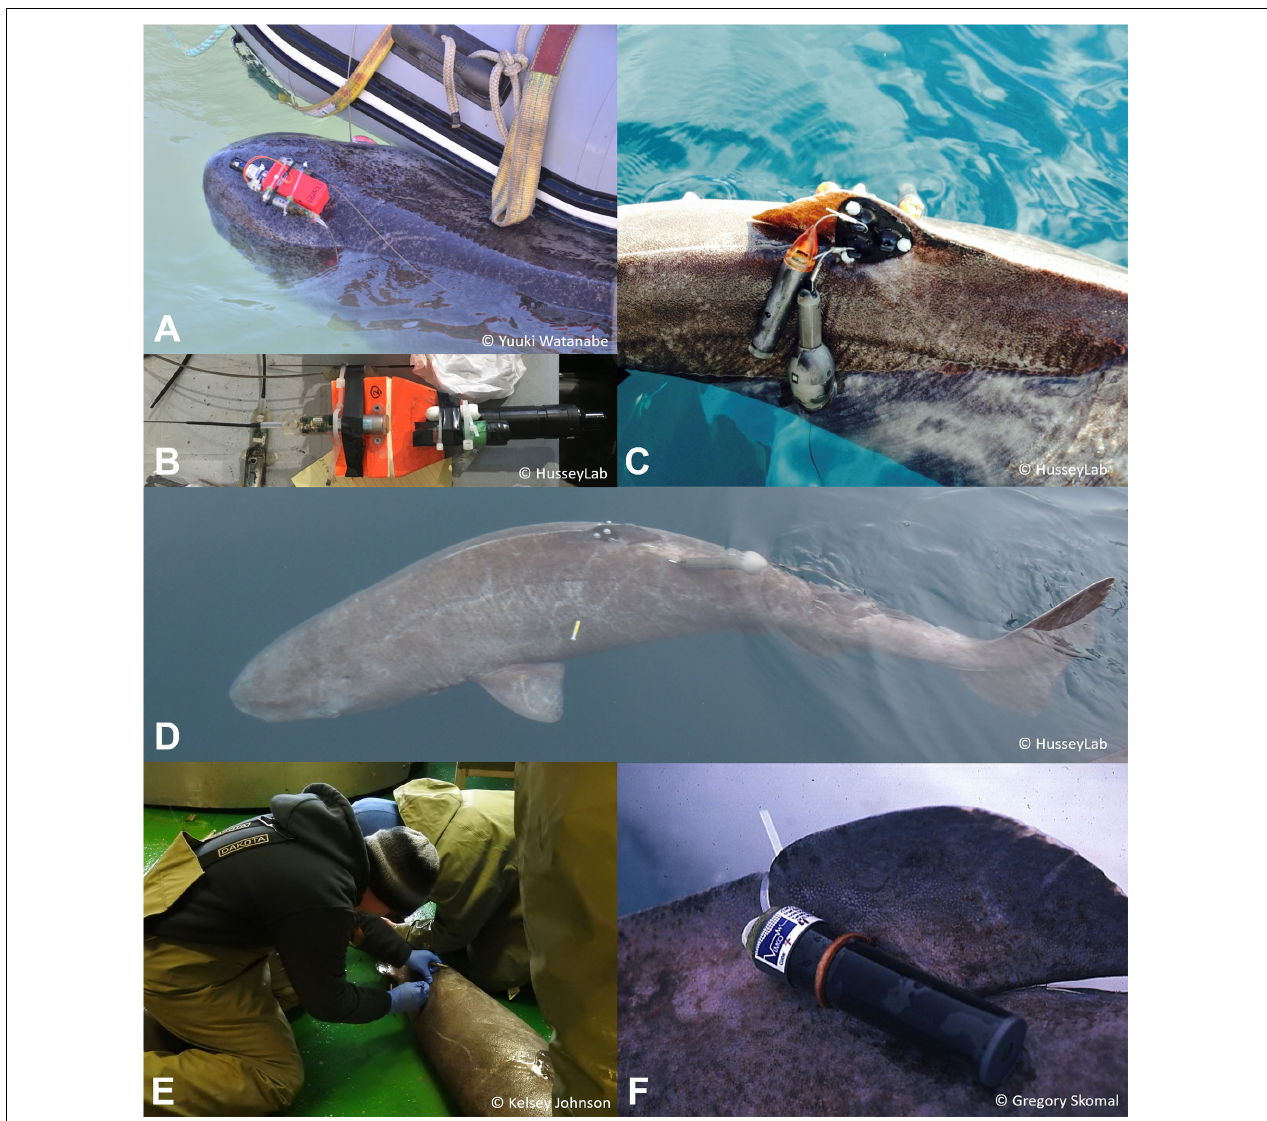
FIGURE 3 | Examples of Greenland shark movement studies: (A) A biologging package containing an accelerometer (Little Leonardo) mounted to the head (photo © Yuuki Watanabe, used with permission). (B) A biologging package containing a spot 6 tag (Wildlife Computers), a VHF tag, an accelerometer (Maritime Biologgers), and a CTD (Star Oddi) (photo © HusseyLab, used with permission). (C) An archival satellite tag and multiple mrPAT tags (Wildlife Comupters) mounted to the dorsal fin (photo © HusseyLab, used with permission). (D) A fin-mounted archival satellite tag (Wildlife Computers) and external marker tag (photo © HusseyLab, used